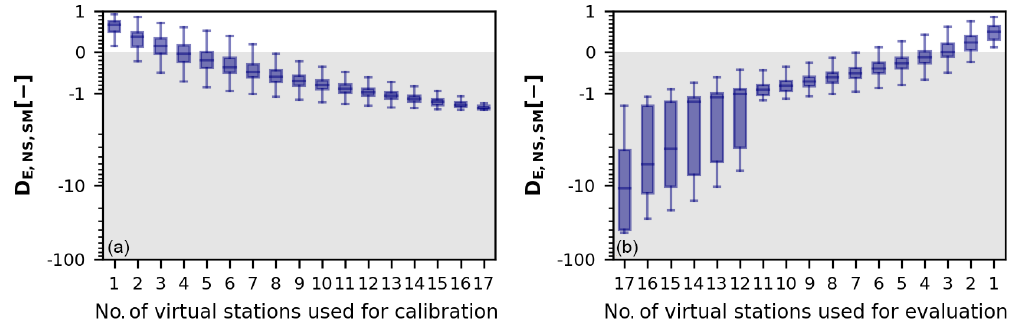
Figure 12. Influence of the number of virtual stations used for (a) model calibration and (b) evaluation on the model performance D E,NS,SM applying Altimetry Strategy 3.